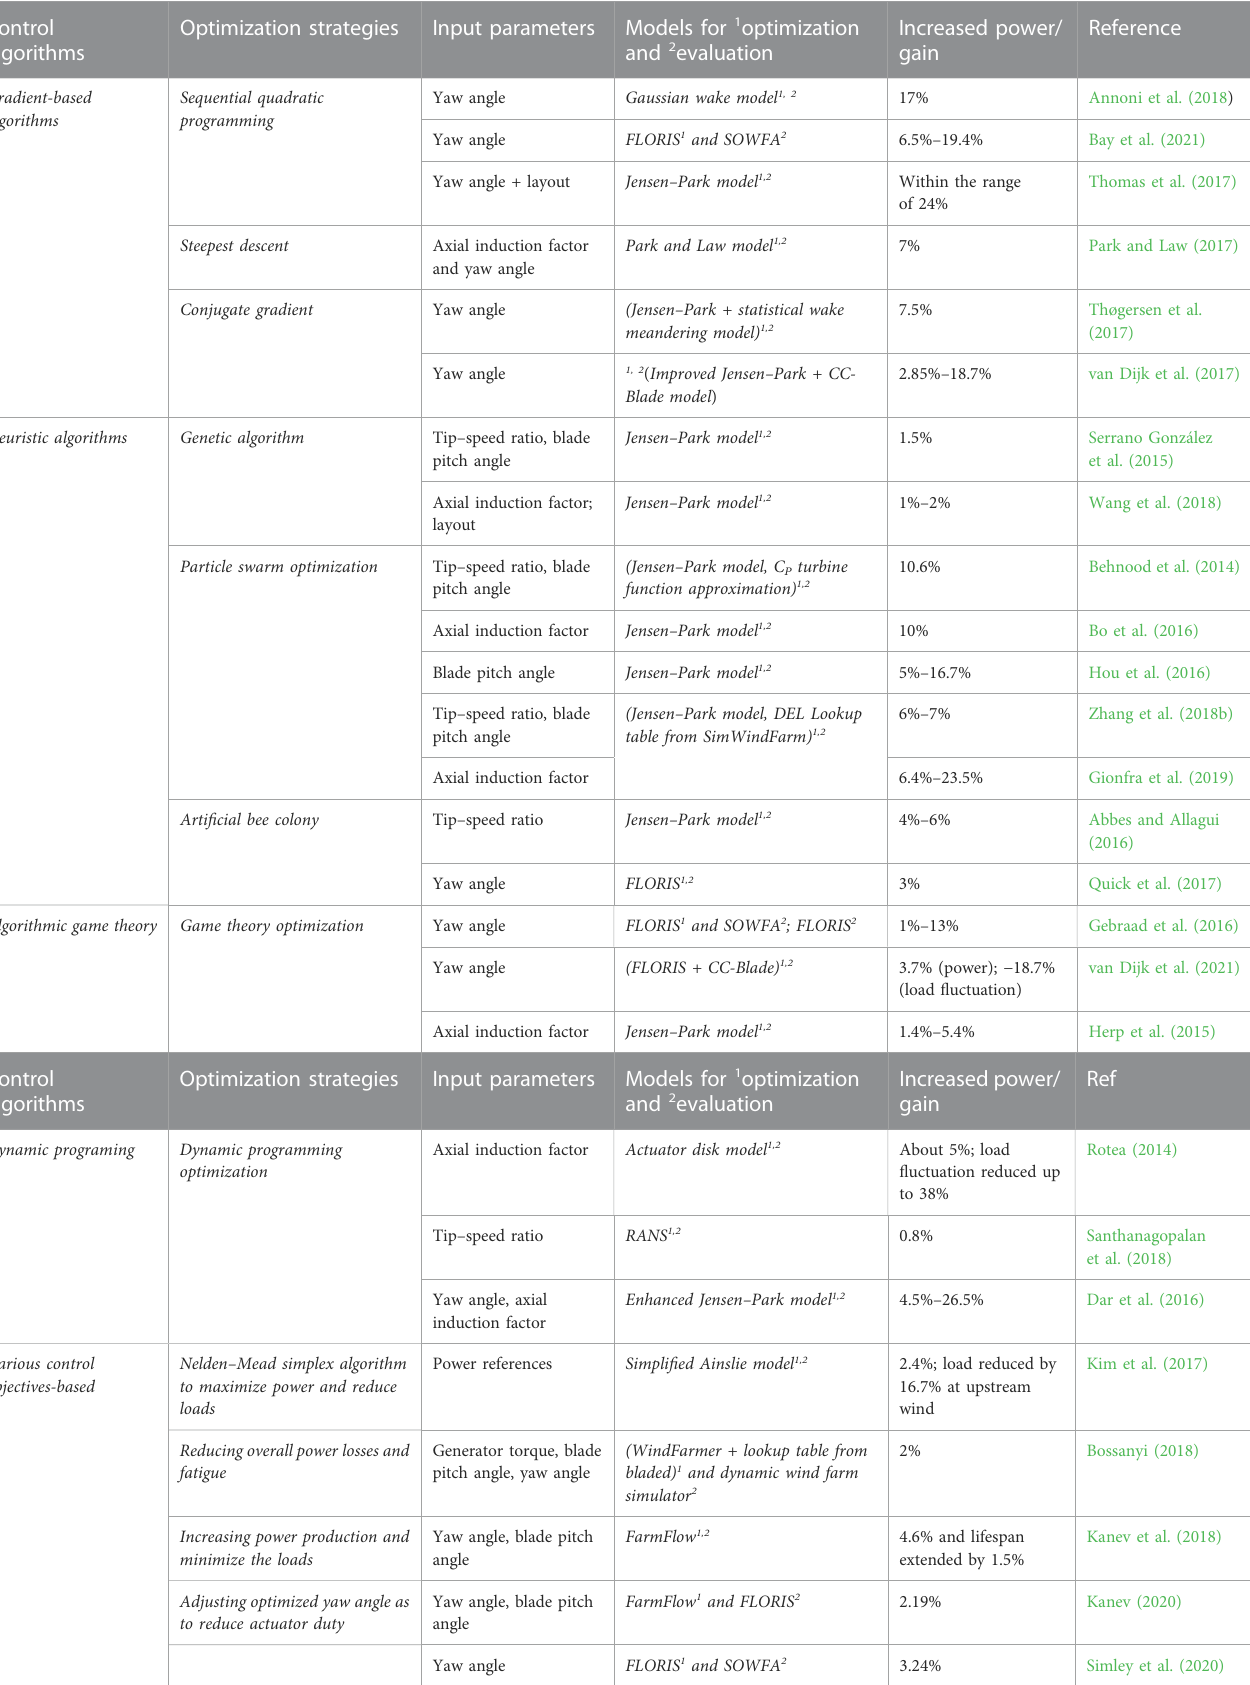
TABLE 5 Performances of feedforward control strategies with different optimization and evaluation